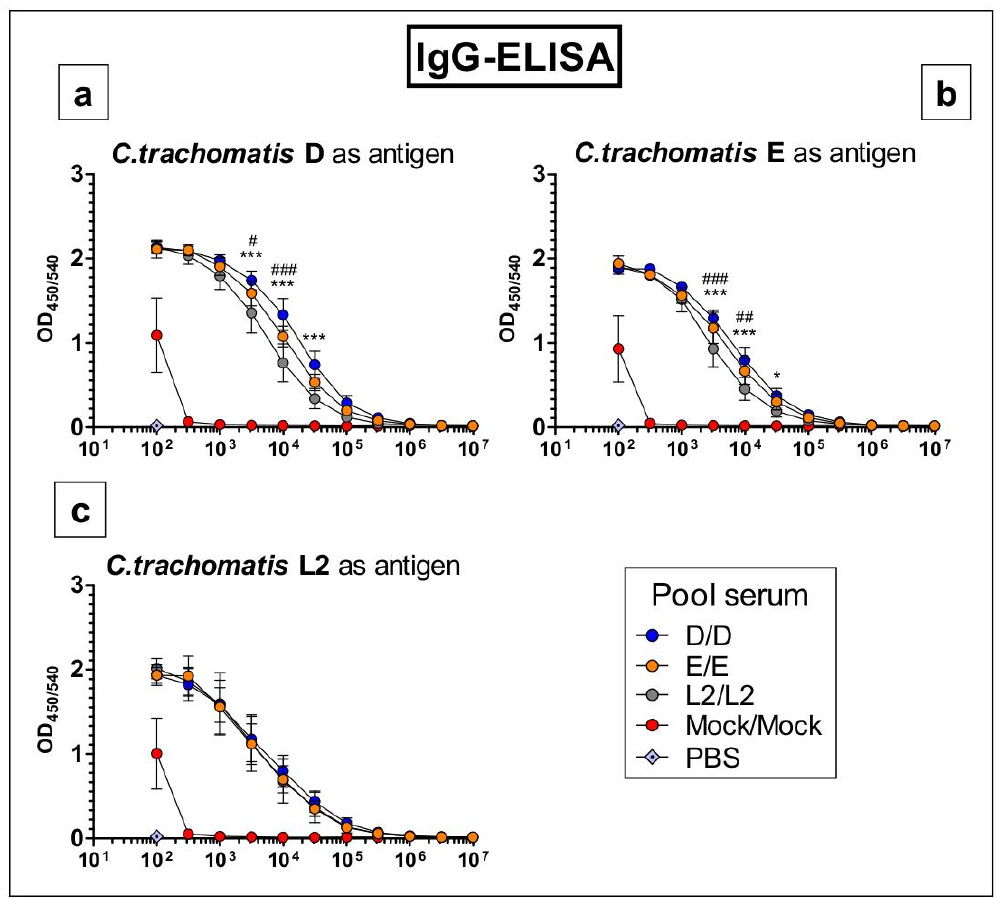
Figure 6. The specific IgG responses against C.tr. D ( a ), E ( b ), and L2 ( c ) homogenates determined in mouse serum pools obtained 7 days after homologous primary and secondary infection of mice with the three C.tr. serovars are very similar. ELISAs detecting IgG directed against either 2.5 µg/well C.tr. D, E or L2 cell homogenate were performed with pool sera obtained from n = 7 (D/D), 8 (E/E), 6 (L2/L2), and 4 (Mock) individual mice 7 days after secondary infection with the same serovar. Serial dilution started at 1:100 and continued in 1:3.16 steps (1:316, 1:1000 …) until 1:10 mil. PBS controls were applied at a dilution of 1:100. Experiments were repeated at least once with duplicates measured for each individual dilution. The performed statistical analysis is described in Section 2. *–*** indicates statistical significances between the D/D and L2/L2 pool sera and #–### indicates statistical significances between the E/E and L2/L2 pool sera with p < 0.05, <0.01, and <0.001, respectively.